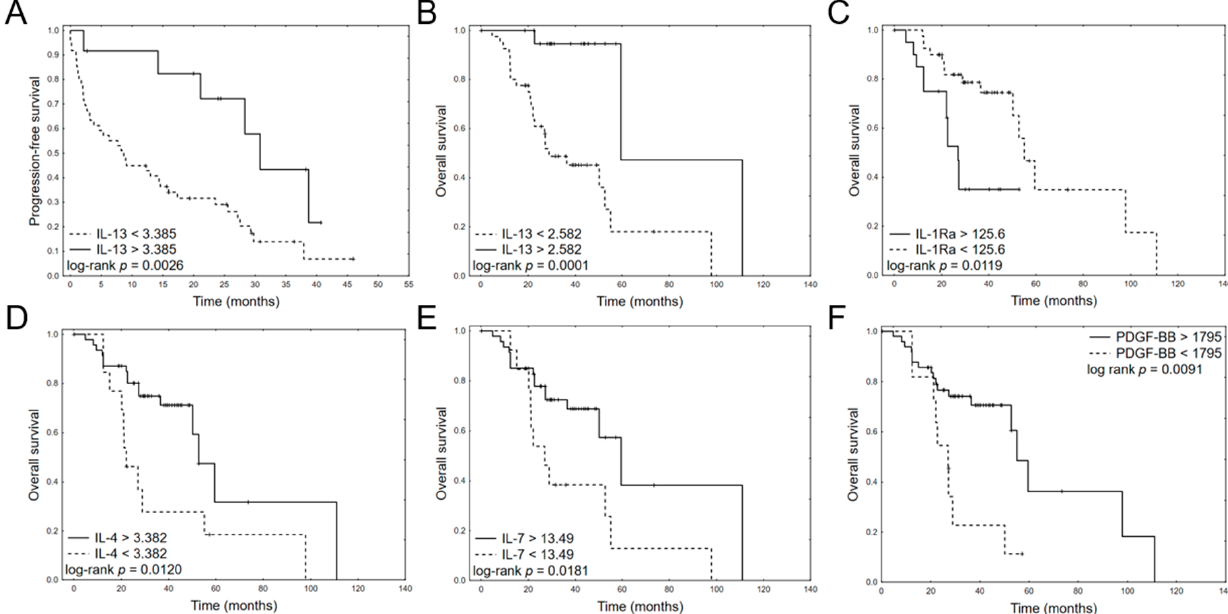
Figure 2. Kaplan–Meier plots for dichotomized significant cytokines in univariate analysis: PFS: IL-13 ( A ) and OS: IL-13 ( B ), OS: IL-1Ra ( C ), OS: IL-4 ( D ), OS: IL-7 ( E ), OS: PDGF-BB ( F ). Table 4. Final multivariate Cox regression analyses for PFS and OS of MM patients. Cytokine concentrations (pq/mL) were divided by 10 to allow a more straightforward interpretation of coeffi- cient